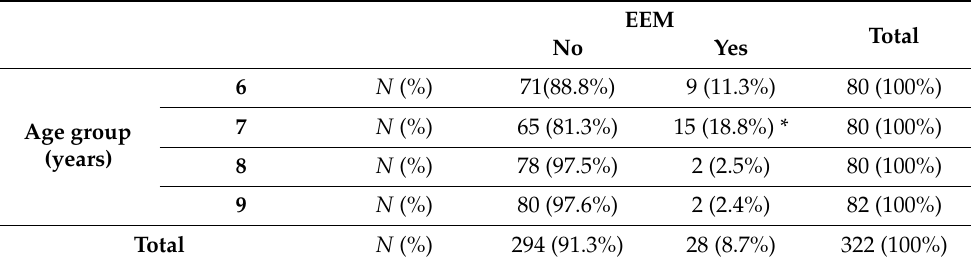
Table 3. Ectopic eruption of the maxillary first permanent molar. Age